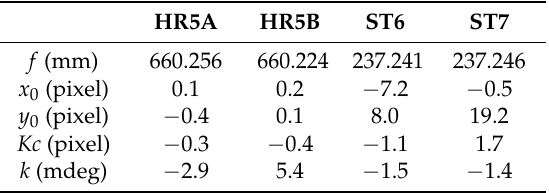
Table 1. Lab-calibrated camera parameters for moms-2p [46,48].